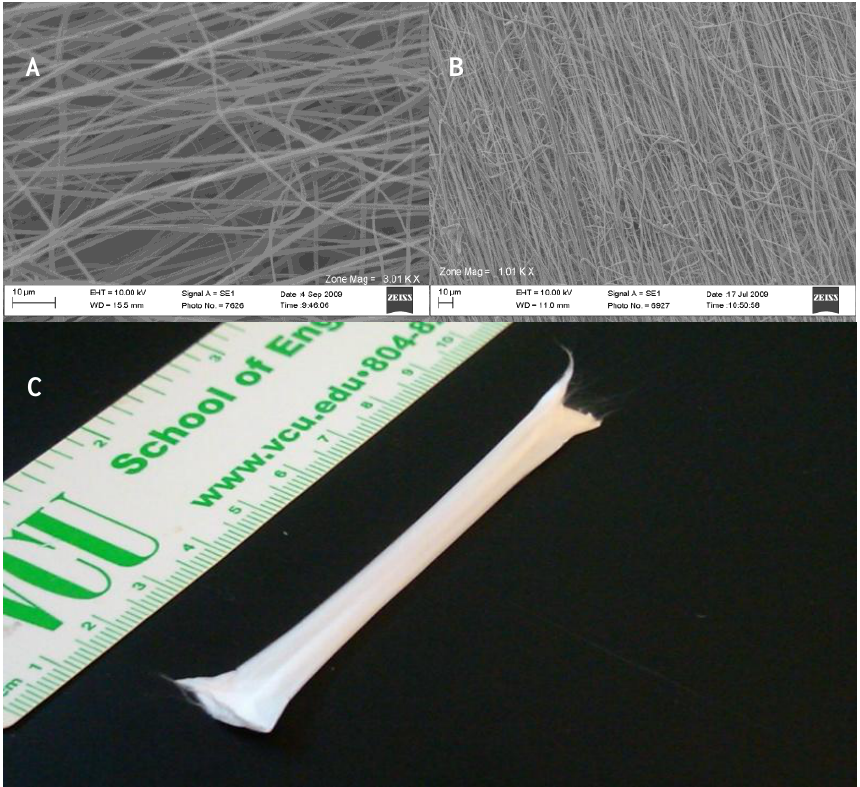
Figure 9. SEMs of SPCL airgap electrospun structures demonstrating the high porosity outer shell (A, image at 3000×), the tightly wound inner core (B, image at 1000×), and a digital photograph of the multilayered structure (C). SEM scale bars = 10